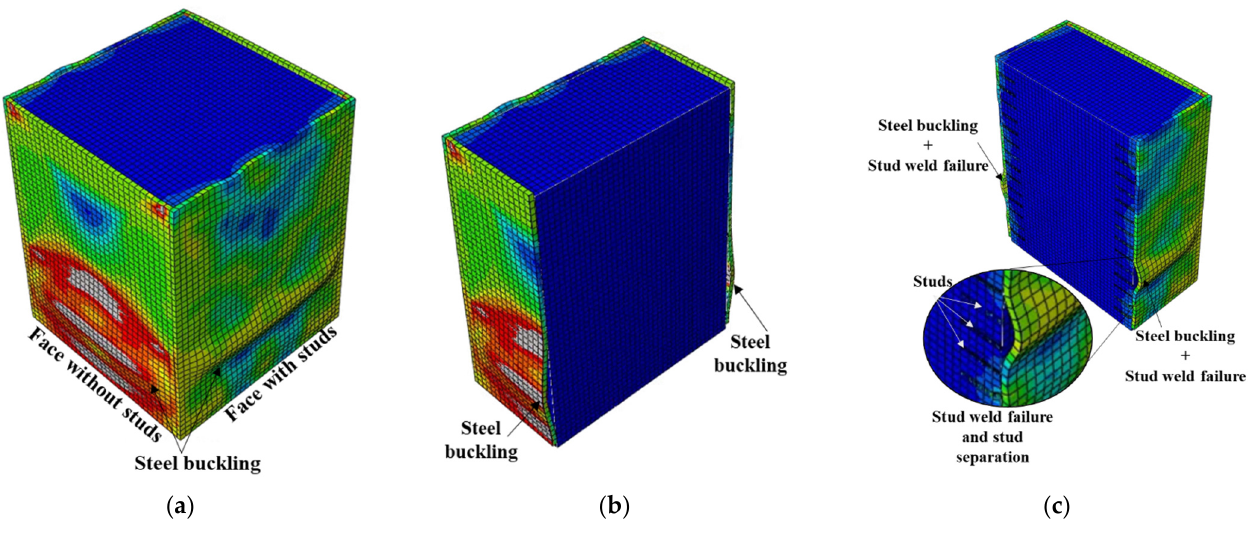
Figure 11. Failure mode of S2-Sp100D19L150 (closely spaced stud on two parallel faces): ( a ) steel tube buckling, ( b ) outward buckling of faces without studs, and ( c ) outward buckling and stud weld failure.